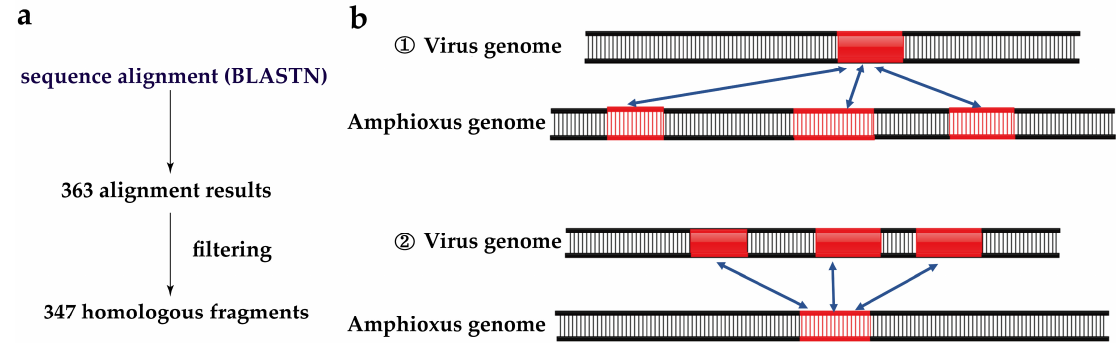
Figure 1. The detection method for HFs and the schematic diagram for HFs. ( a ) The simplified pipeline for detecting HFs. ( b ) The concrete schematic diagram for HFs. There were 2 situations of alignment. A fragment of viral sequences aligned with multiple DNA fragments in the B. belcheri beihai genome. Multiple fragments of viral sequences aligned with the same DNA fragment in the B. belcheri beihai